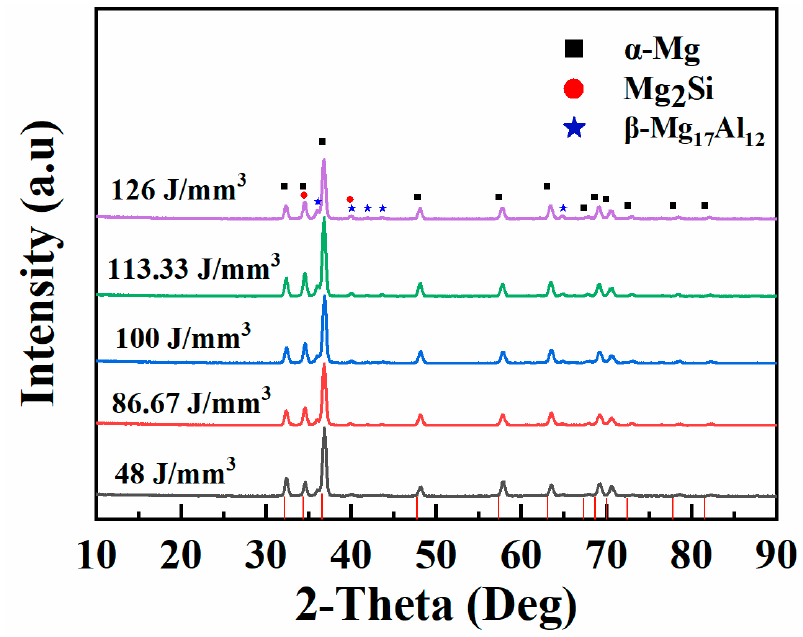
E Figure 4. XRD patterns of the SLM samples at different E v. Figure 4. XRD patterns of the SLM samples at different v . The metallographic microscope photograph of samples at different E v is displayed in E Figure 5. The metallographic microscope photograph of the cross-sectional sample with v laser energy density at 80 J/mm 3 is shown in Figure 5a,b. There were closely striated scanning trajectories, and Figure 5a clearly shows a closely striated scanning trajectory, and in Figure 5b, there is an overlapping region (OLR) between the molten pools during the scanning process. The grain size in the sample is slightly larger than the center of the tracks (CST) due to the reheating process. Meanwhile, overlapping regions make the sample bonding better because of the existence of overlapping regions. Figure 5c,d show the longitudinal section track of the sample, and the tracks of Figure 5c,d are different. When E v is 65 J/mm 3 in Figure 5d, the bottom of the sample appears elliptical by the Gaussian distribution of laser energy aligned layer by layer. However, in Figure 5c, when the E v is 80 J/mm 3 , the width of the molten pool increases with the increase of E v. The ratio of width to height of the molten pool causes the bottom elliptical feature to be covered, and the longitudinal elliptical track tends to be flat. Figure 3g is a schematic diagram of a track forming a flat vertical section. When the laser energy density increases, the width-height ratio of the molten pool continues to change, and the layer-like elliptical features become prominent again. At the same time, the depth of the molten pool is several times the thickness of the layer, and each layer will be reheated several times during the forming process [18]. This forming process allows for a good metallurgical bond between adjacent tracks and